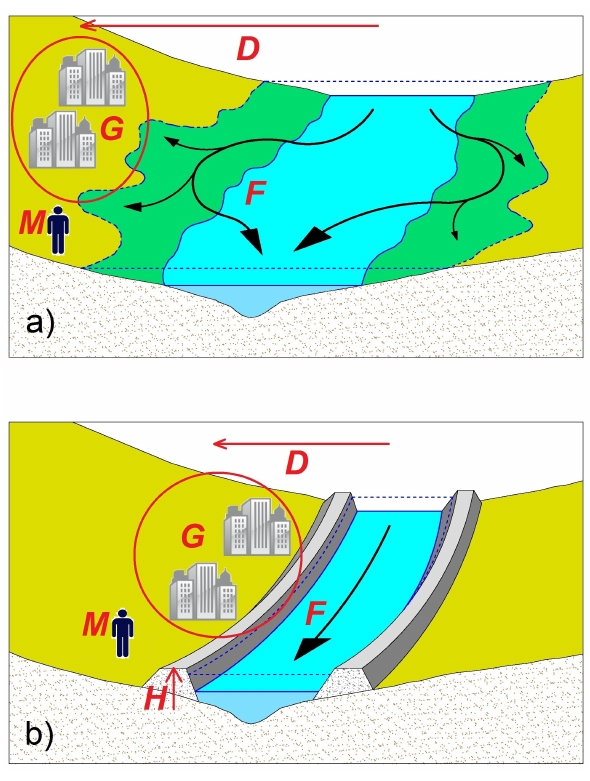
Fig. 1. Schematic of human adjustments to flooding: (a) settling away from the river, and (b) raising levees or dikes. The diagrams also show variables used in our conceptualisation: F is the intensity of flooding [.]; G is the size of human settlement [L 2 ]; D is the distance from the river [L]; H is the flood protection levels [L]; M is the awareness of the risk of flooding [.]. (Based on a sketch by Domenico Di